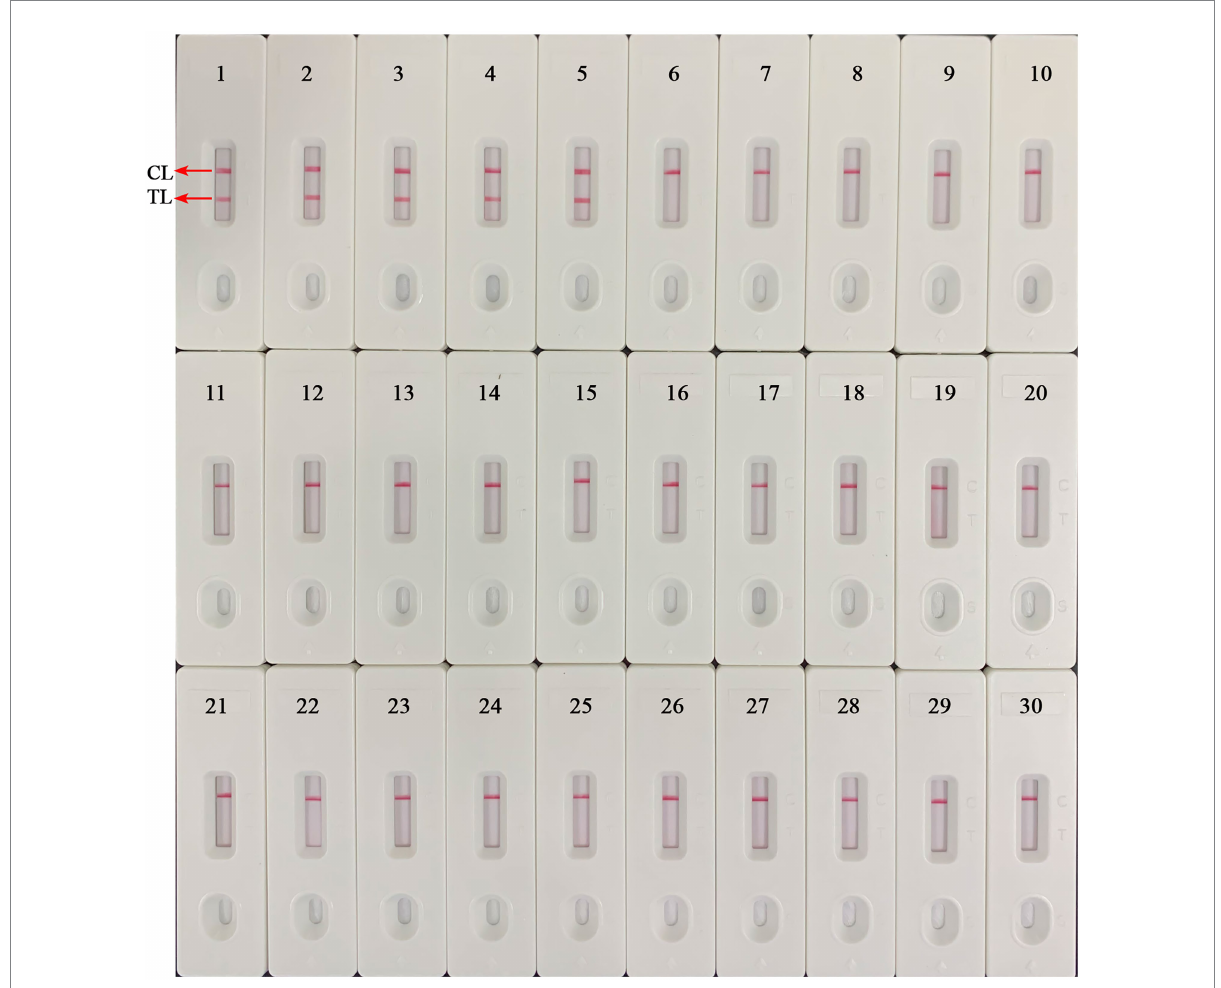
FIGURE 7 Analytical specificity of the B. abortus -MCDA-LFB assay. The genomic DNA extracted from 28 bacterial strains was used to evaluate the analytical specificity of the B. abortus -MCDA-LFB assay. Biosensor 1, B. abortus 544 (ATCC 23448); Biosensor 2, B. abortus (vaccine strain); Biosensors 3–5, B. abortus isolates (GZCDC); Biosensor 6, B. melitensis 16 M (ATCC 23456); Biosensor 7, B. melitensis M5 (vaccine strain); Biosensor 8–13, B. melitensis isolates (GZCDC); Biosensors 14, B. suis 1330S (ATCC 23444), Biosensors 15, B. suis S2 (vaccine strain); Biosensors 16, B. canis isolate (GZCDC); Biosensors 17–28, Mycobacterium tuberculosis H37Rv (ATCC 27294), Mycobacterium bovis (ATCC 19210), Listeria monocytogenes (GZCDC), Klebsiella pneumoniae (GZCDC), Streptococcus pneumoniae (GZCDC), Pseudomonas aeruginosa (GZCDC), Haemophilus influenzae (GZCDC), Staphylococcus aureus (GZCDC), Shigella sonnei (GZCDC), Bacillus anthracis (GZCDC), Streptococcus suis (GZCDC), Salmonella spp. (GZCDC); Biosensors 29–30, negative control (environmental sample in the test) and blank control (nuclease-free water). MCDA, multiple